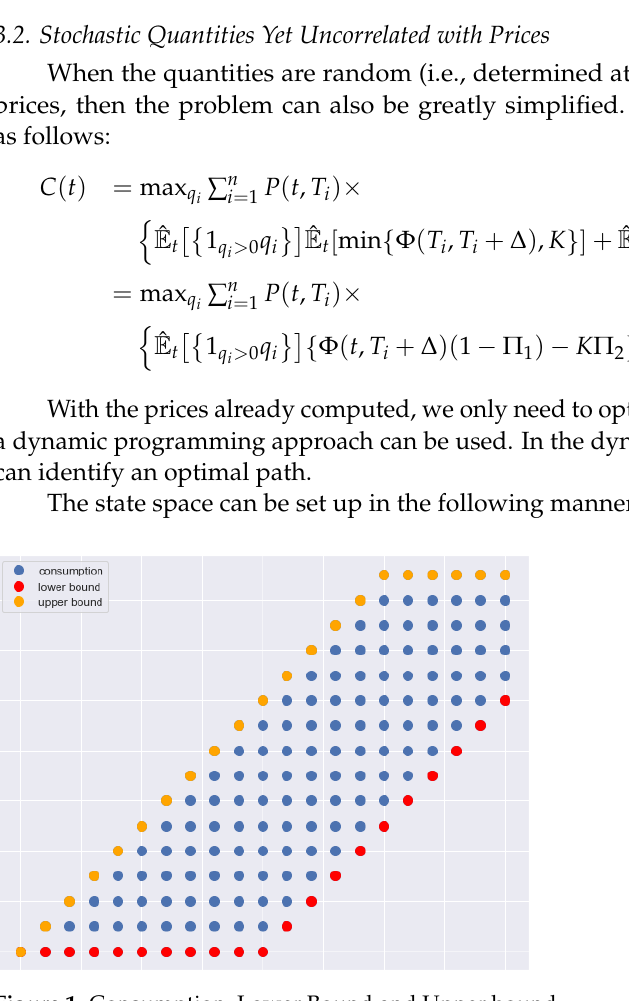
Figure 1. Consumption, Lower Bound and Upper bound .